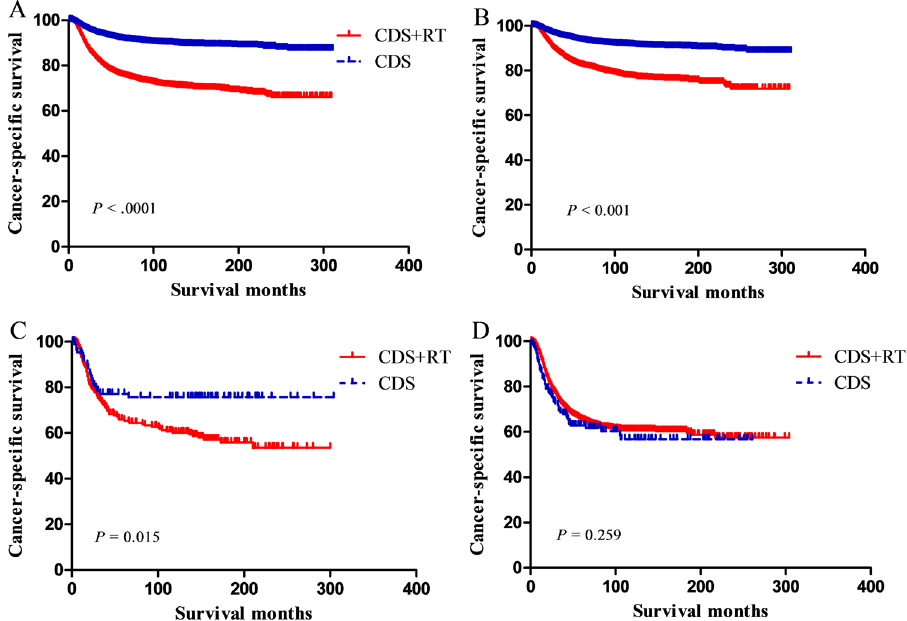
Figure 1. Cause-specific survival of patients with FIGO stage IB-IIB ( A ), IB ( B ), IIA ( C ) and IIB ( D ) with different local treatment